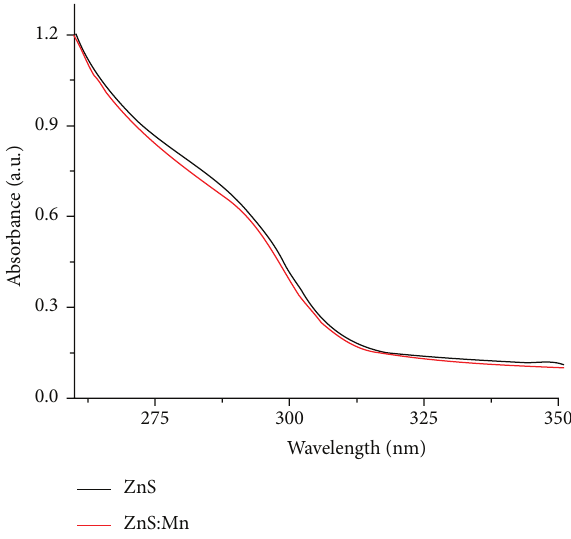
Figure 3: UV-visible spectra of ZnS QDs (black) and ZnS:Mn 2+ QDs